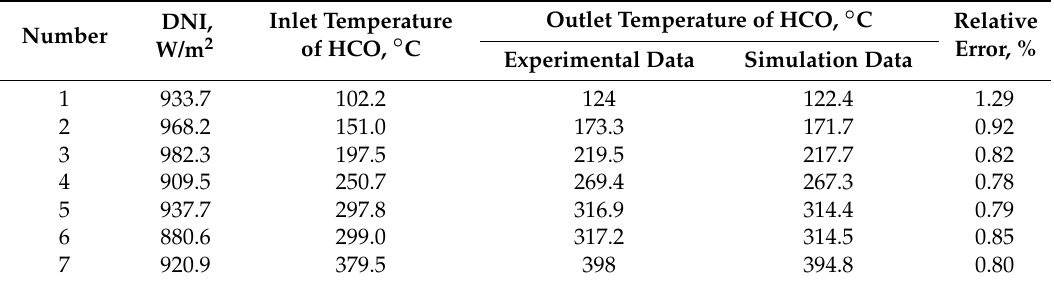
Table 2. Relative error of the outlet temperature of heat conducting oil (HCO) in the parabolic trough collector (PTC) model. DNI—direct normal irradiance.